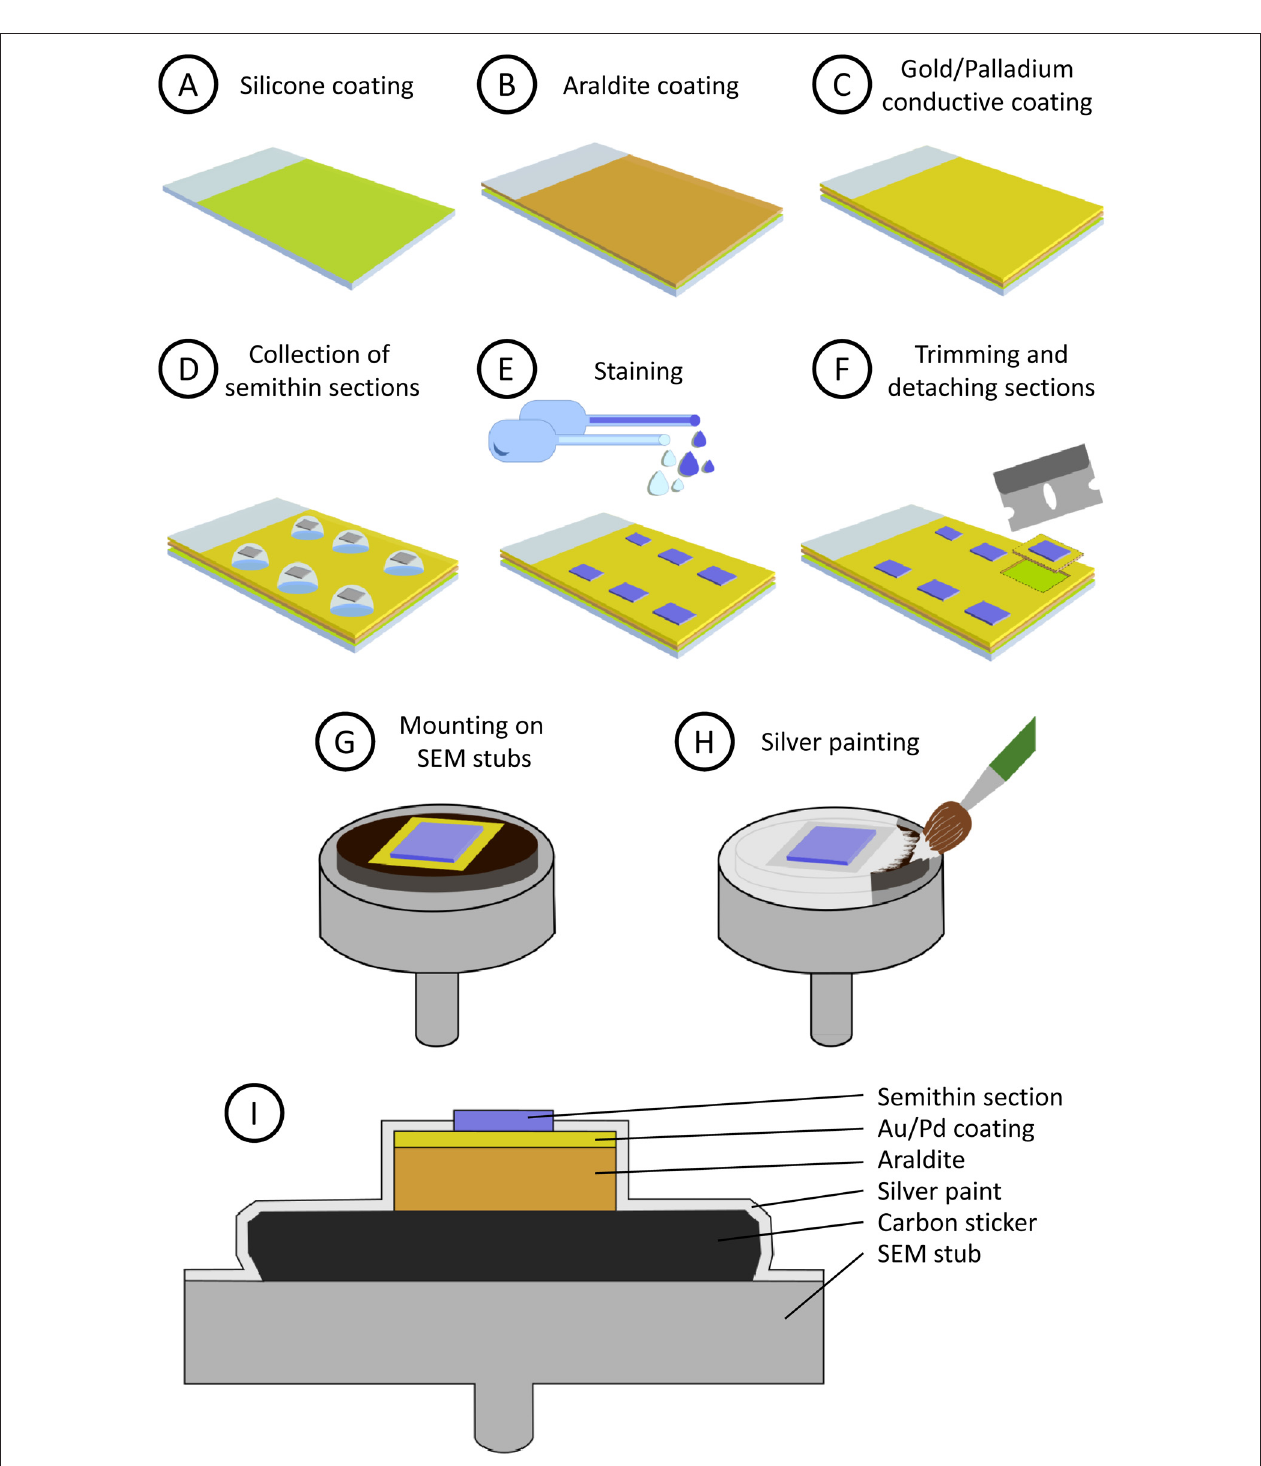
FIGURE 1 | Step-by-step preparation and mounting of semithin sections (see “Methods” section). (A) Microscope glass slides are covered with silicone. (B) A layer of Araldite is poured and polymerized on the siliconized glass slide. (C) The glass slide is then sputter-coated with gold/palladium to make it conductive. (D) Semithin sections are collected on water drops and dried on a hot plate. (E) Semithin sections are stained for light and electron microscopy (EM). (F) Selected sections are trimmed and detached from the slide. Note that the silicon layer prevents the Araldite from firmly adhering to the glass, so the square of Araldite supporting the section can be detached easily. (G) Mounting of the semithin section on an aluminum scanning electron microscopy (SEM) stub. (H) Conductive silver painting to avoid charge build-up. (I) Summarized depiction of the semithin section once mounted on the SEM stub (not to scale).